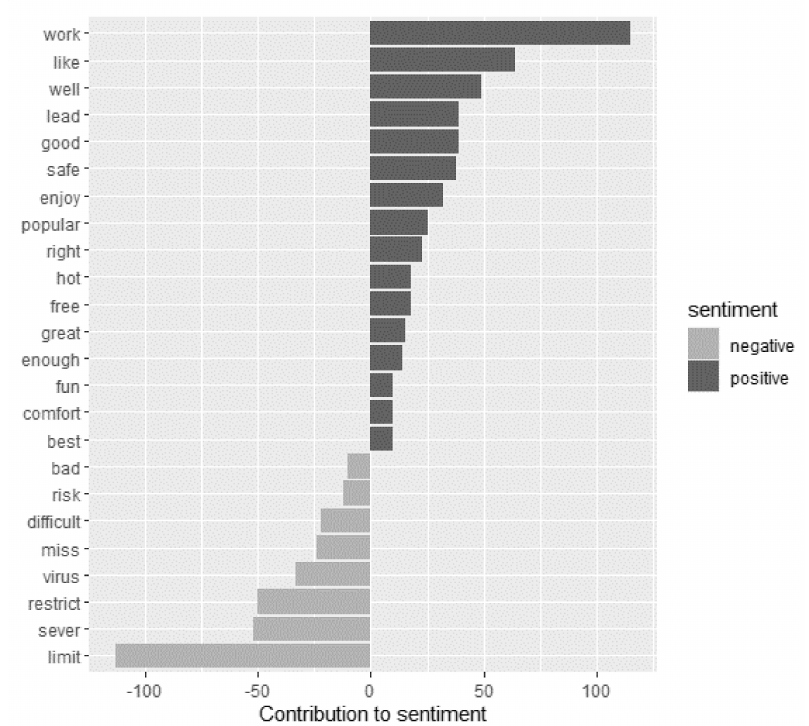
Figure 3. Words of the 2020 comments with the greatest contribution to the positive and negative sentiments. Words of all comments were compared to the terms presented in the sentiment lexicon “afinn”, which assigns scores from − 5 to 5, with negative scores indicating negative and positive scores indicating positive sentiments.